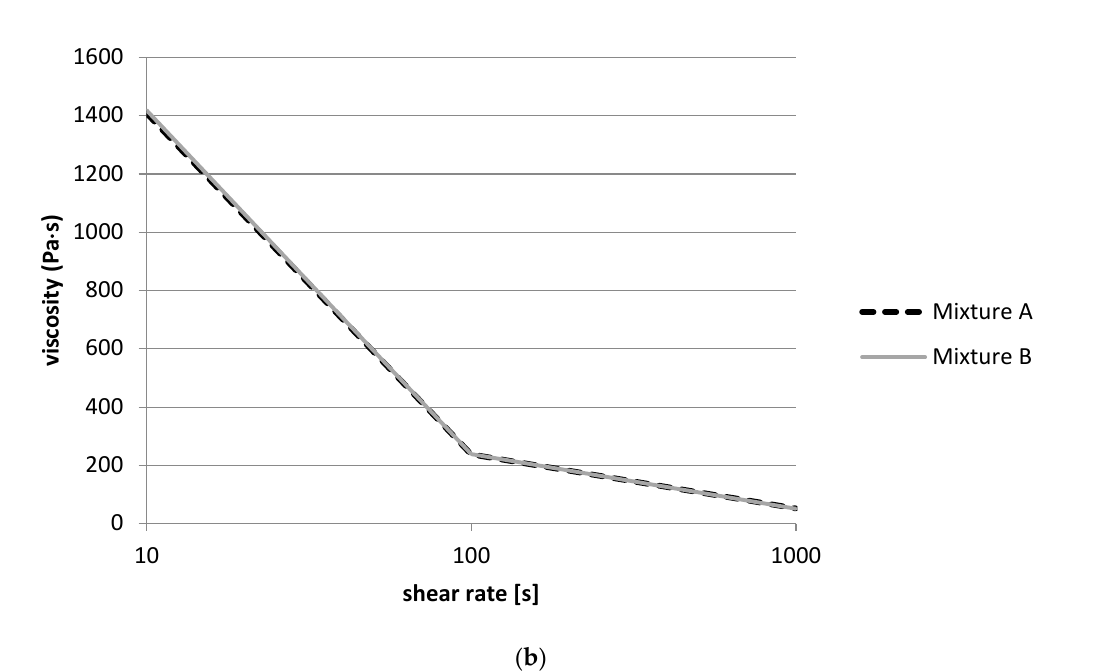
Figure 6. Flow curves of the milk fermented for 24 h with different single strain cultures of Lb. delbrueckii strains 052, 053, and 328M; L. fermentum strains 054, 317, and 339; Lb. helveticus strains 058, 314, and 321; and S. thermophilus strains 252, 363, and 349 ( a ), or with mixed starter strains Lb. helveticus 314, L. fermentum 317, S. thermophilus 252, Lb. delbrueckii 328M, and the yeast Sc. cerevisiae strain 370 (mixture A) or the four lactic acid bacteria strains without the yeast (mixture B) ( b ).